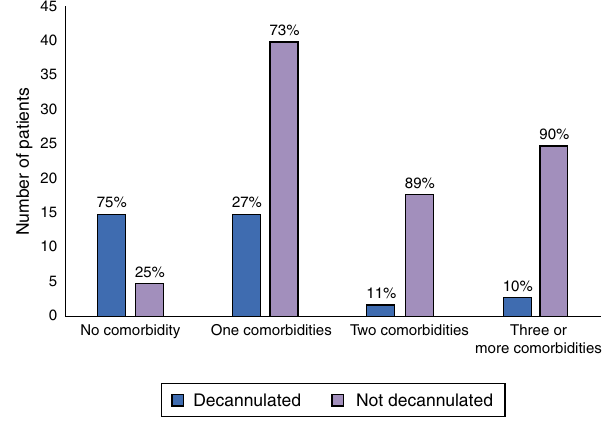
Figure 3 Association between the number of comorbidities and decannulation